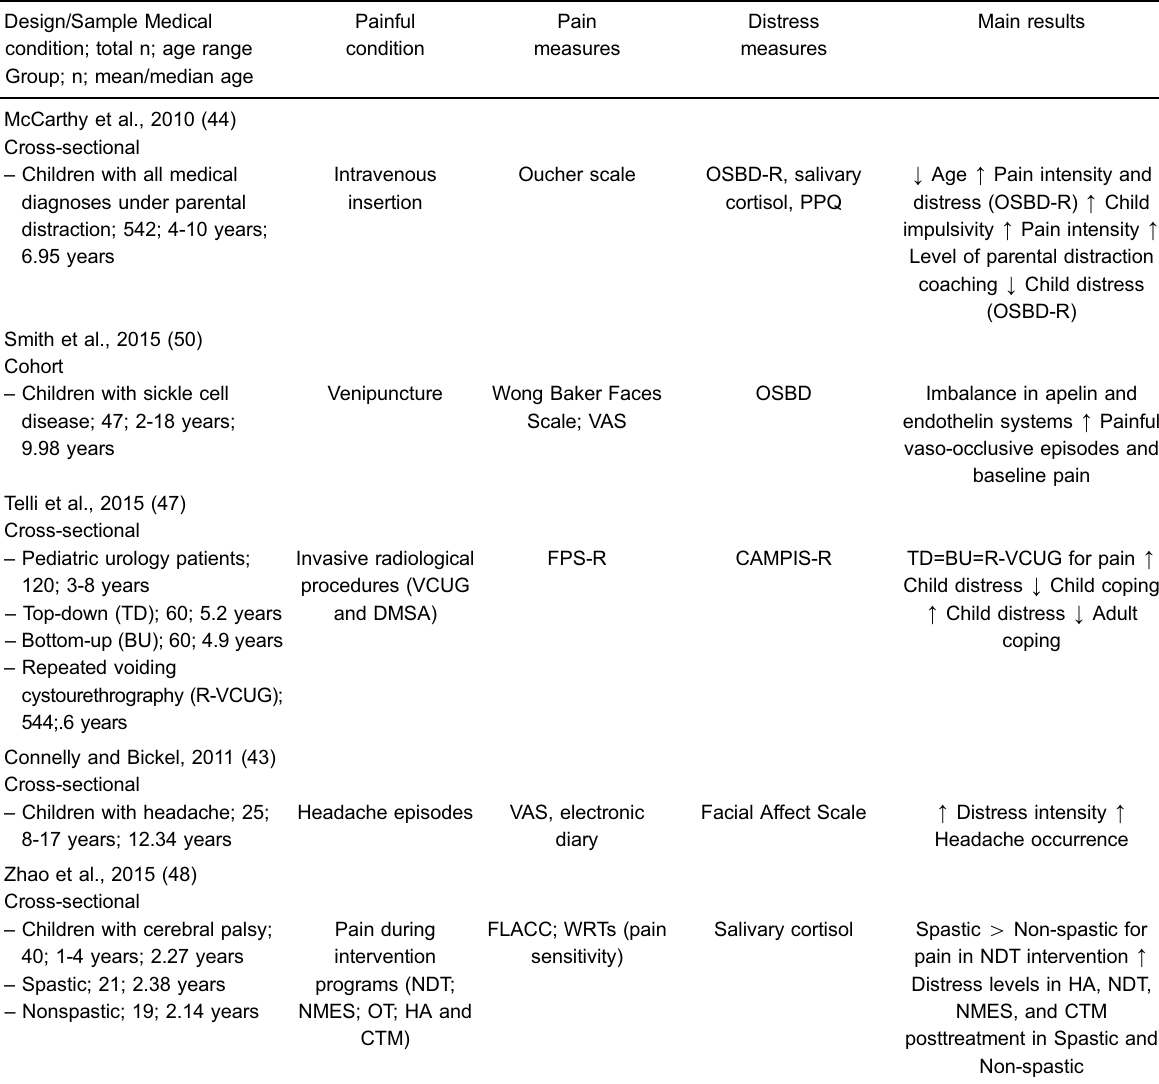
Table 5. Main fi ndings of cross-sectional and cohort studies on pain and distress responses in children (n = 5). Design/Sample